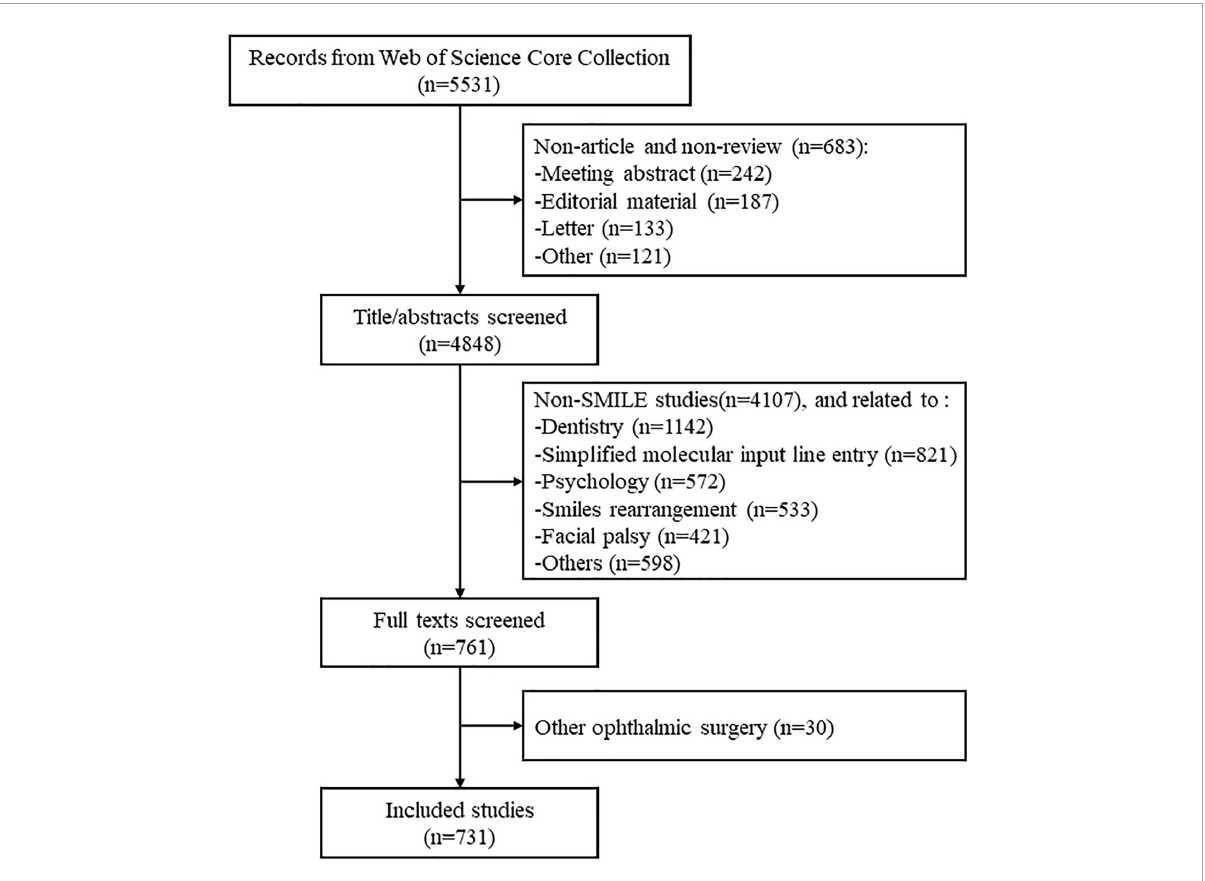
FIGURE1 Results of literature